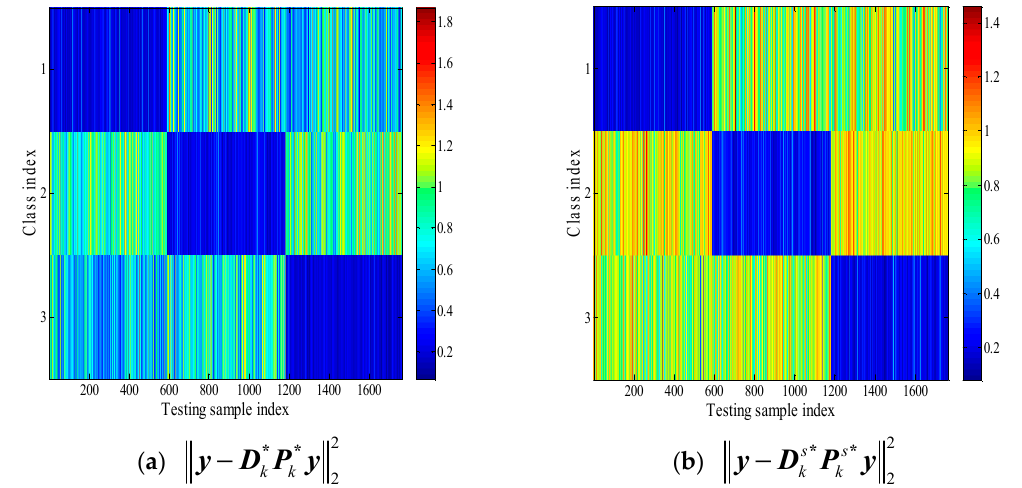
Figure 5. ( a ) Reconstruction error with global aspect training set. ( b ) Reconstruction error with local aspect sector training subset.